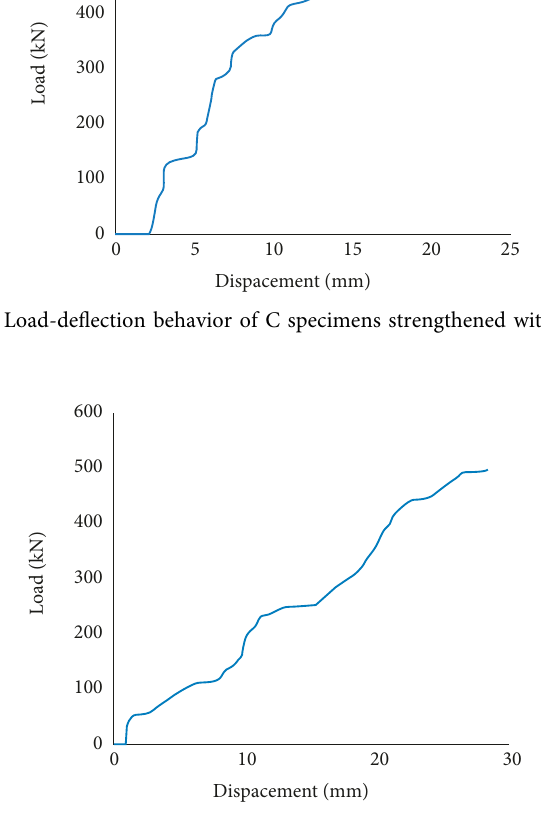
Figure 19: Load-deflection behavior of GG15 specimens strengthened with